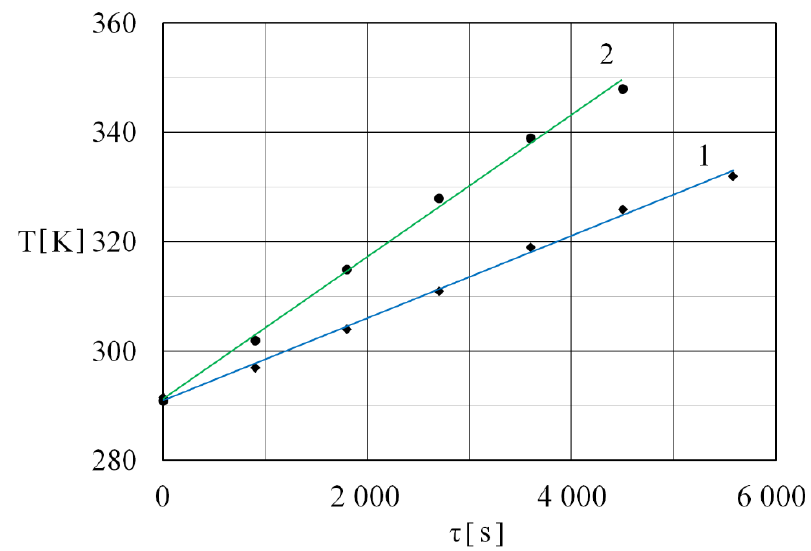
Figure 10. Graph of the heat carrier heating within the one-stage–1 and two-stage–2 disk pulse heat generator.